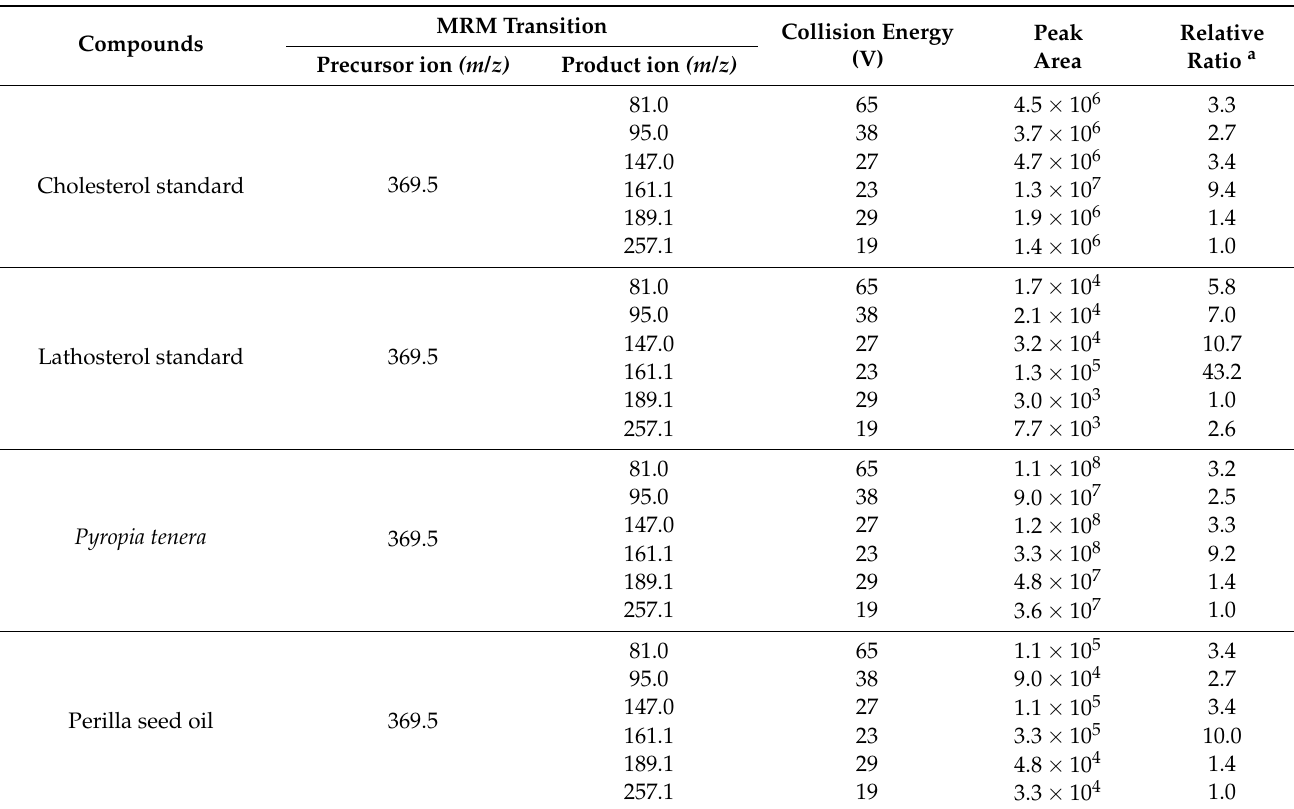
MRM Transition Collision Energy